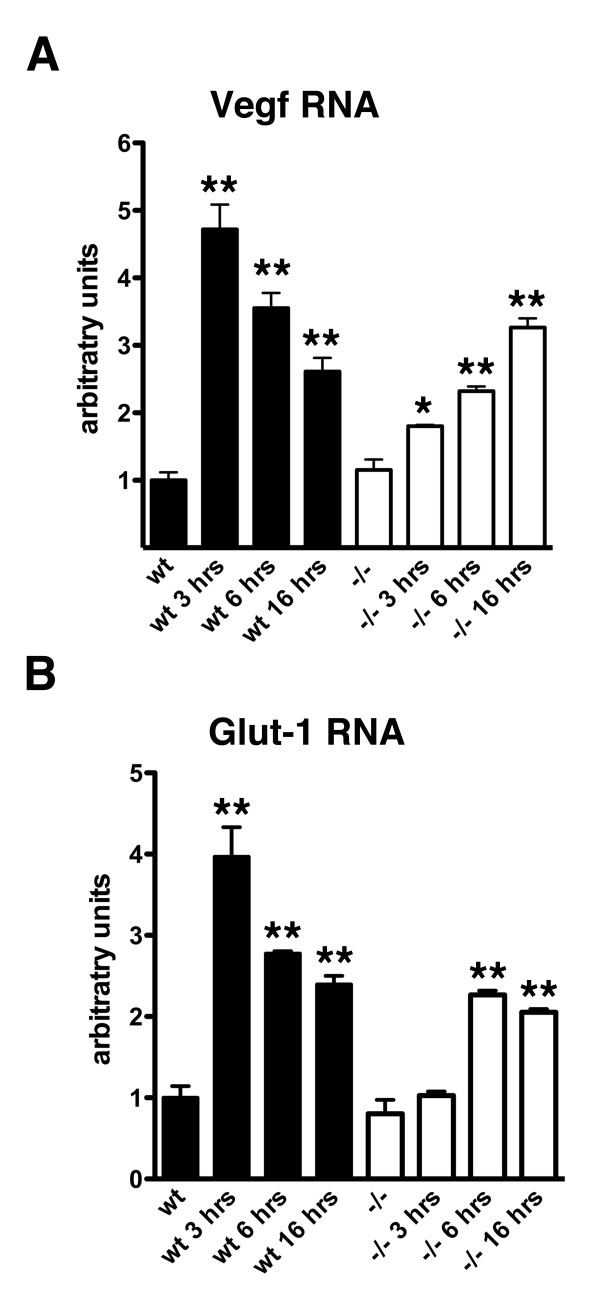
Reduced activation of HIF-1α downstream target genes in Psen1-/- fibroblasts treated with cobalt chloride. Psen1+/+ (wt) or Psen1-/- fibroblasts were treated with cobalt chloride for the indicated times (hours). Levels of Vegf (A) and Glut-1 (B) RNA were determined by qPCR (n = 9 cultures per group untreated; n = 3 per group treated). (*) indicates p < 0.05 and (**) p < 0.01 vs. untreated control by Dunnett's post-test. Statistical comparisons between groups are discussed further in the text.